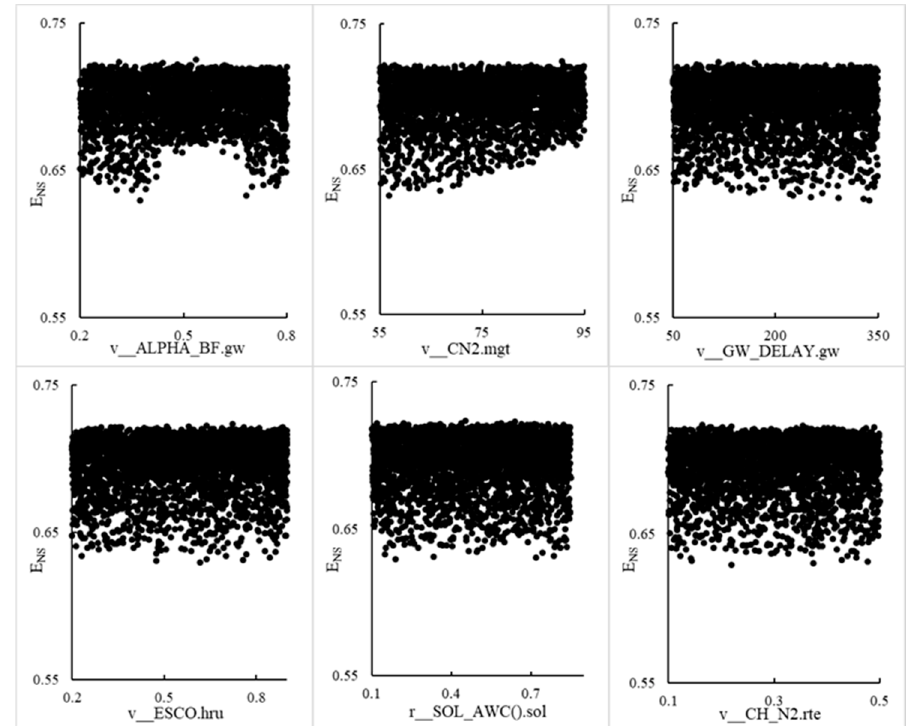
Figure 7. Parameter combination and distribution of Nash–Sutcliffe efficiency coefficient of Xinxue River basin based on GLUE.